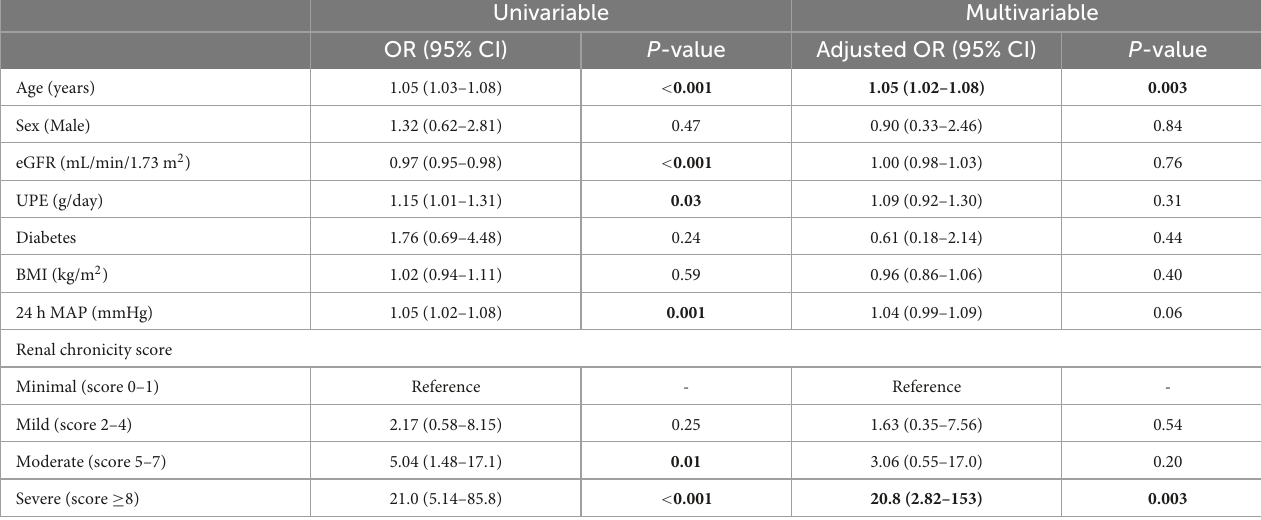
TABLE 5 Univariable and multivariable logistic regression analysis for determinants of non-dipping pulse